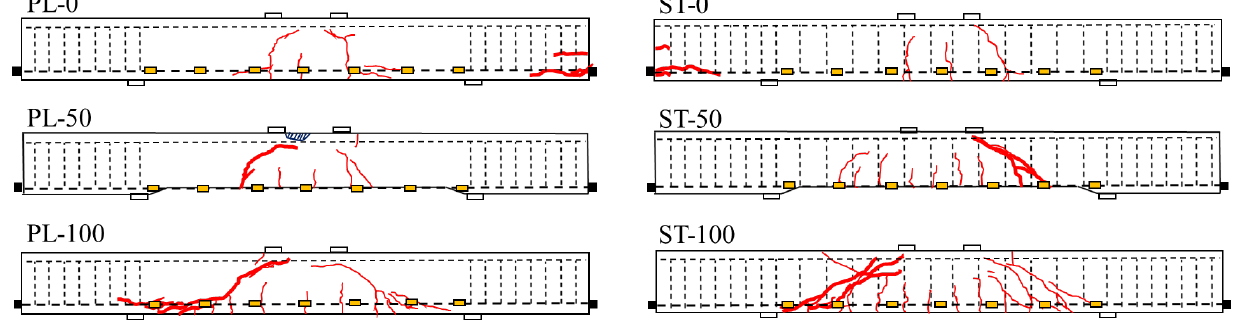
Figure 3. Load – deflection curve ( left : PL series, right : ST series).